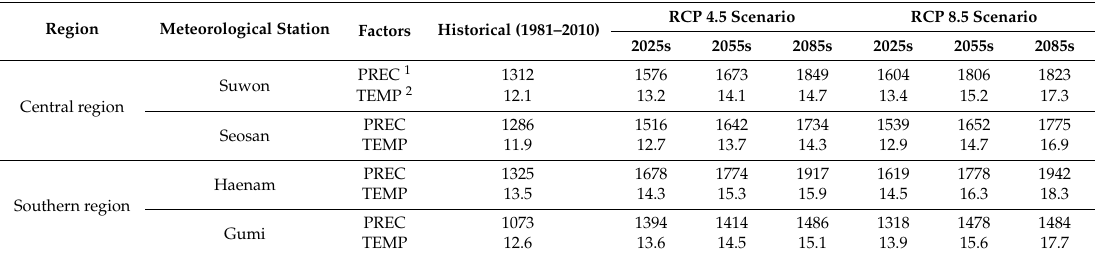
Table 5. Comparisons of meteorological factors between the historical period and climate change